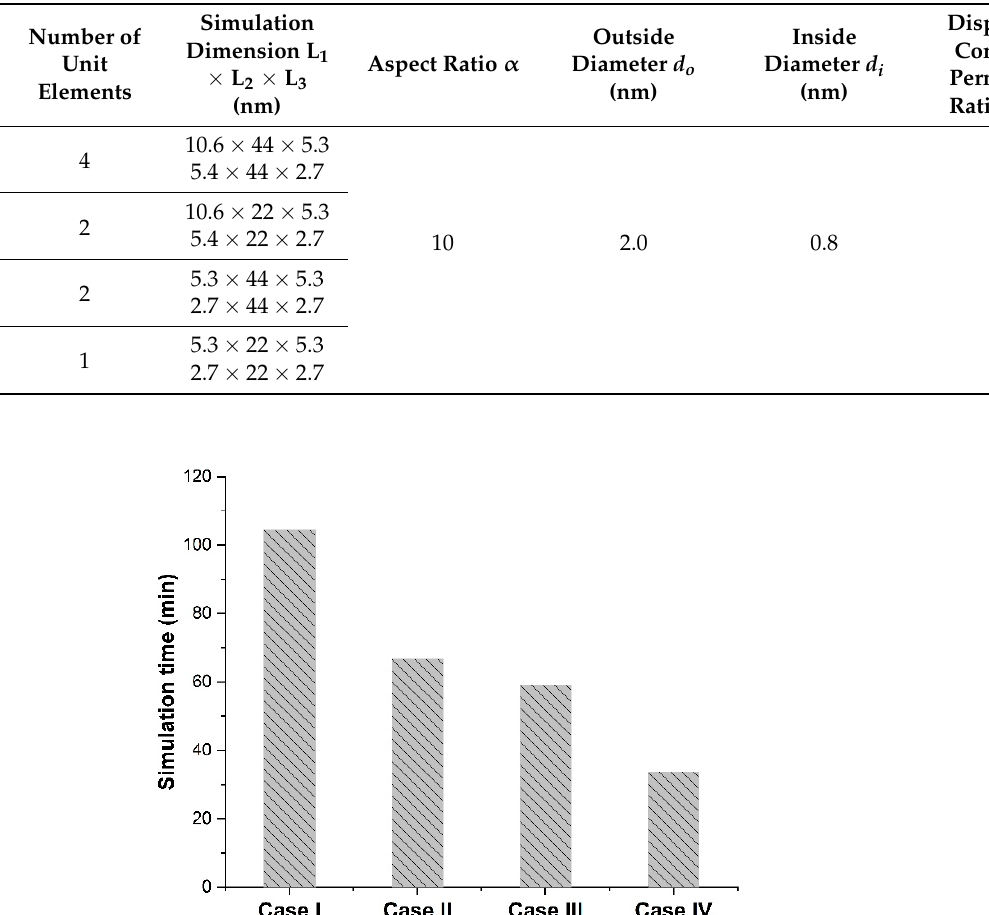
Table 2. Dispersed and continuous phase specifications, which are representative of single-wall carbon nanotubes.